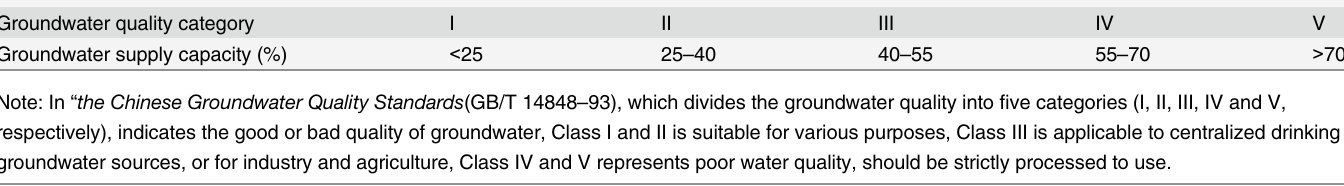
Table 1. The Receptor ranks in the study area. Criteria